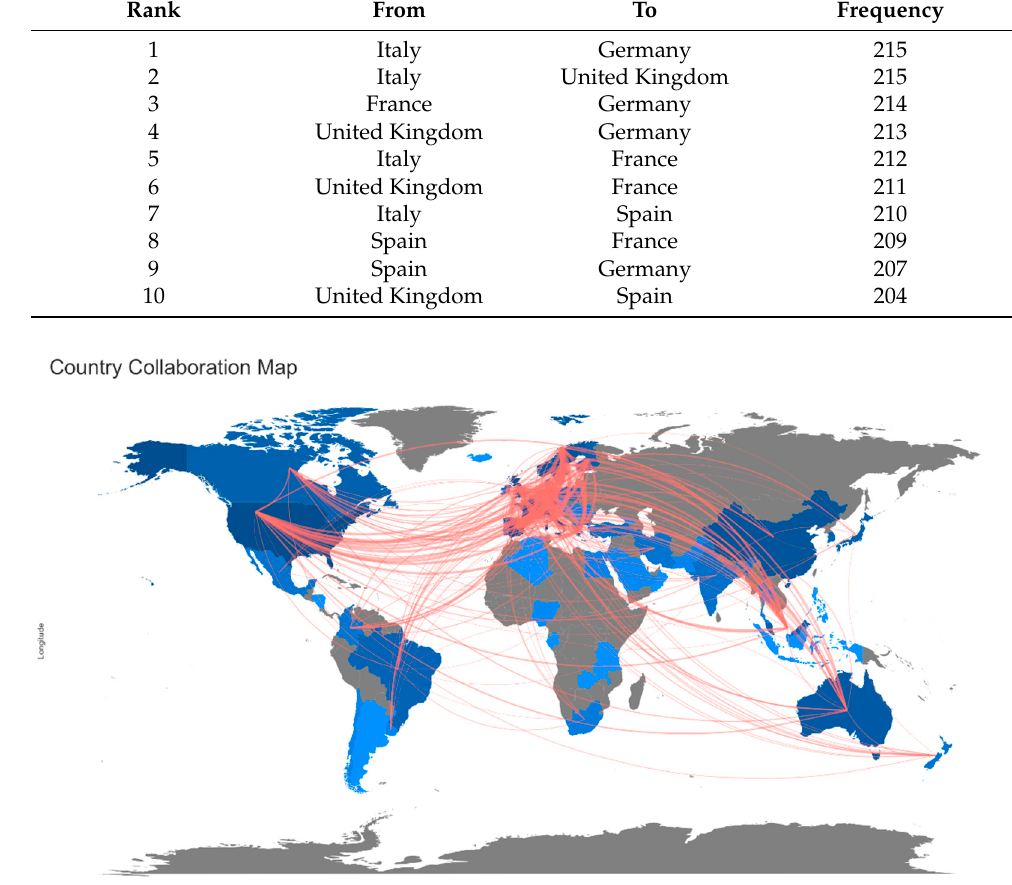
Table 5. Top 10 corresponding authors’ countries.